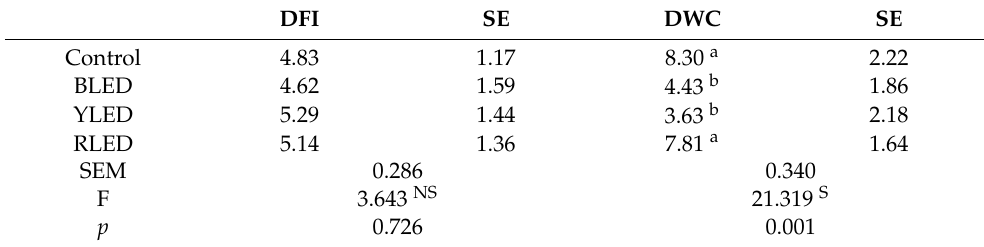
Table 5. Daily food (g/bird) and water consumption (mL/bird) per bird. DFI SE DWC SE Control